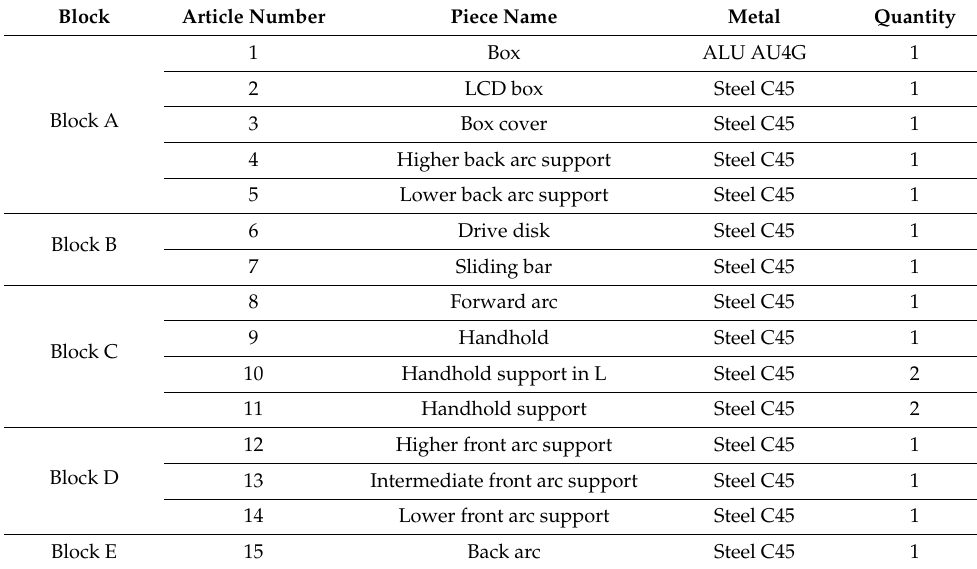
Table 1. Mechanical components.